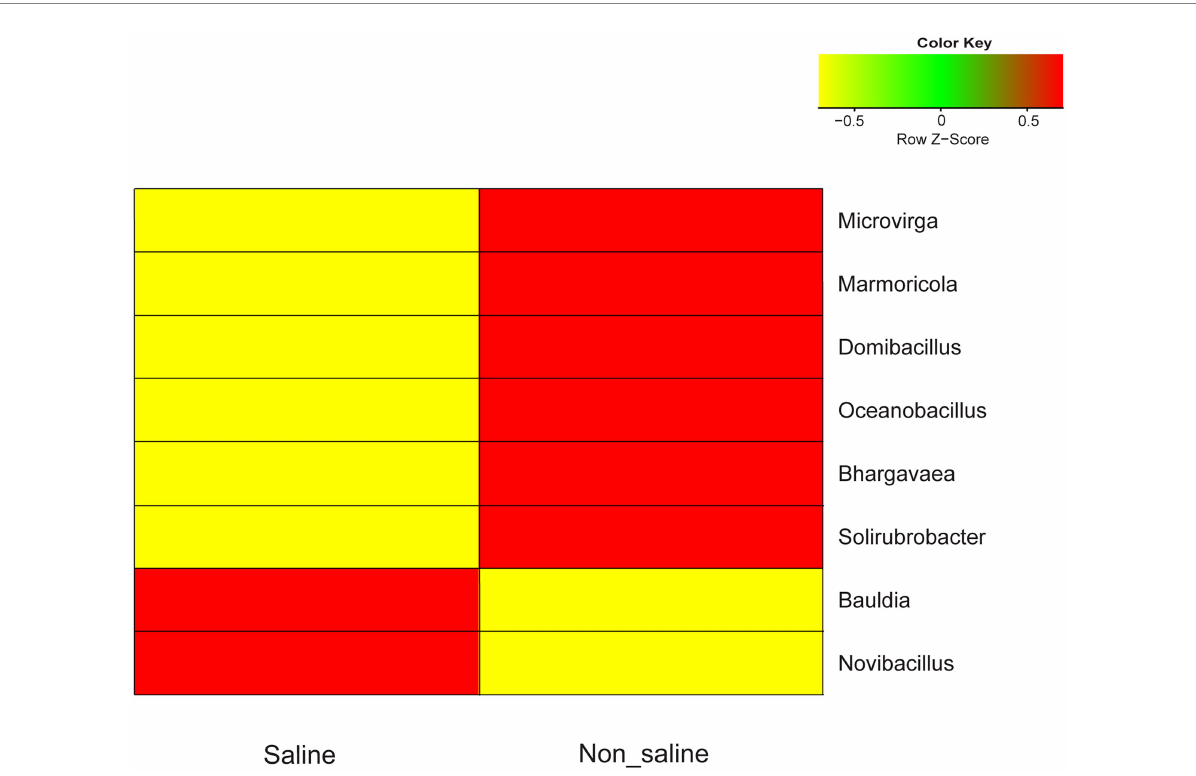
FIGURE 5 Heatmap of bacterial OTU abundances in soil under non-saline water and saline groundwater irrigation. The hierarchical clustering of significant operational taxonomic units (OTUs; p < 0.05) of soil is shown under saline vs. non-saline water irrigation. The color key of the legend indicates the median-centered Z -score values, which were calculated after normalizing the relative abundance values of selected